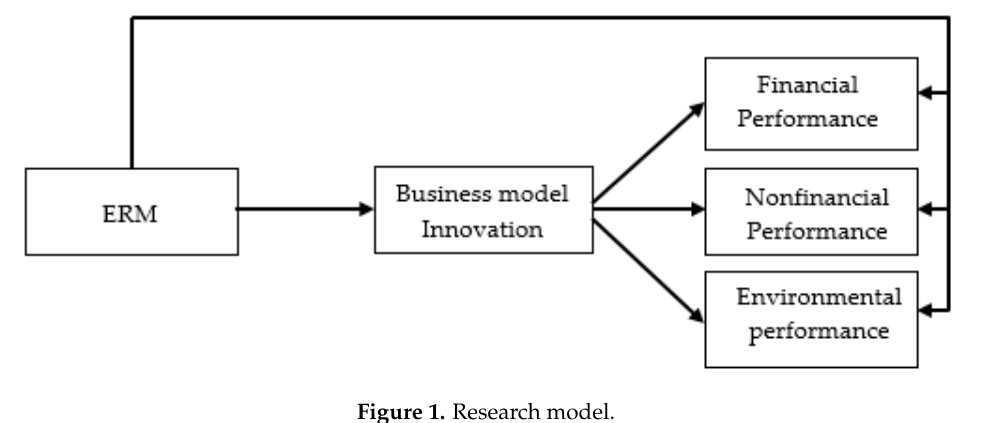
Figure 1. Research model.